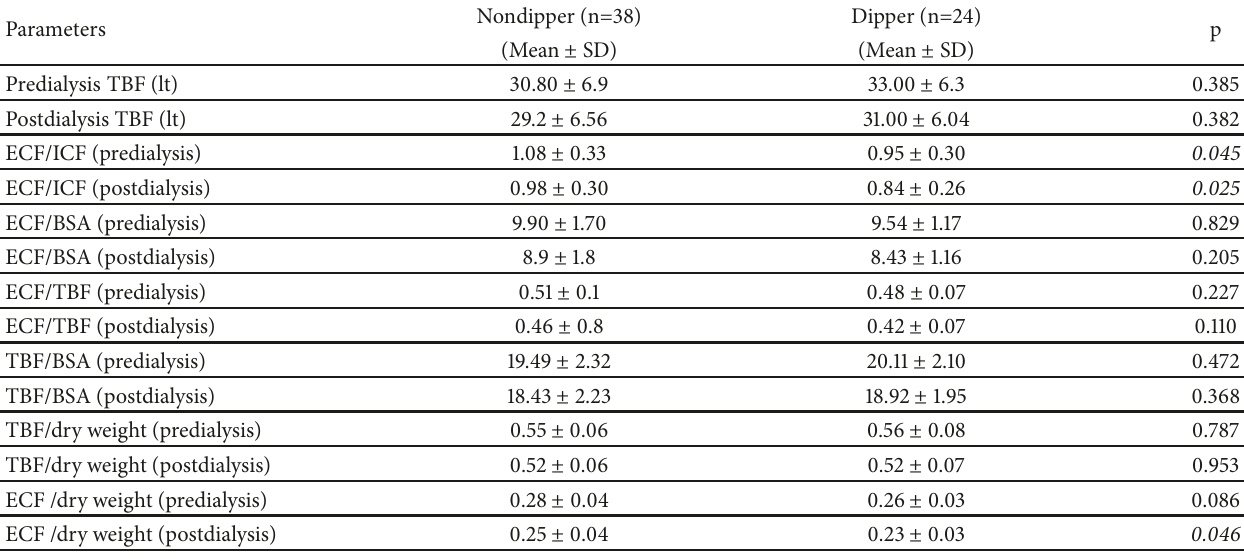
Table 3: Results of bioimpedance in nondipper and dipper patients.